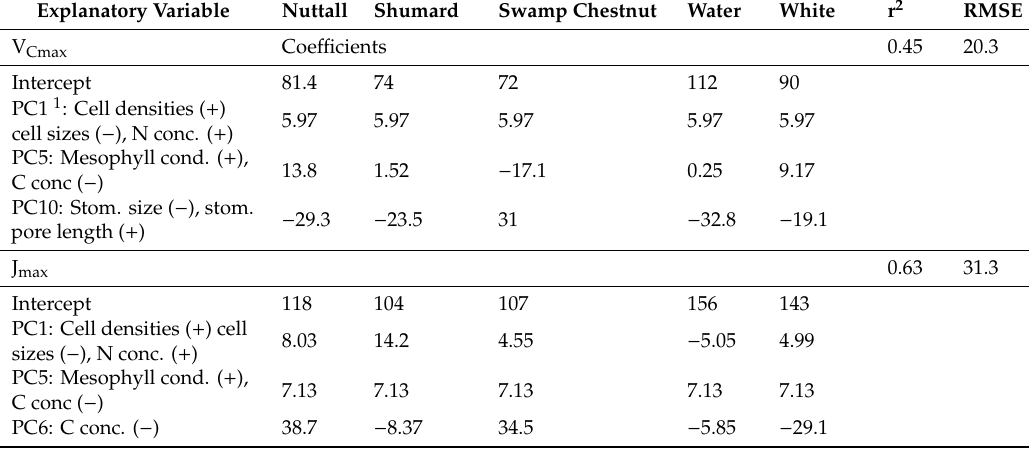
Table 4. Multiple linear regression model results for V Cmax and J max including coe ffi cients for each species, adjusted r 2 values and root mean square error (RMSE) from cross